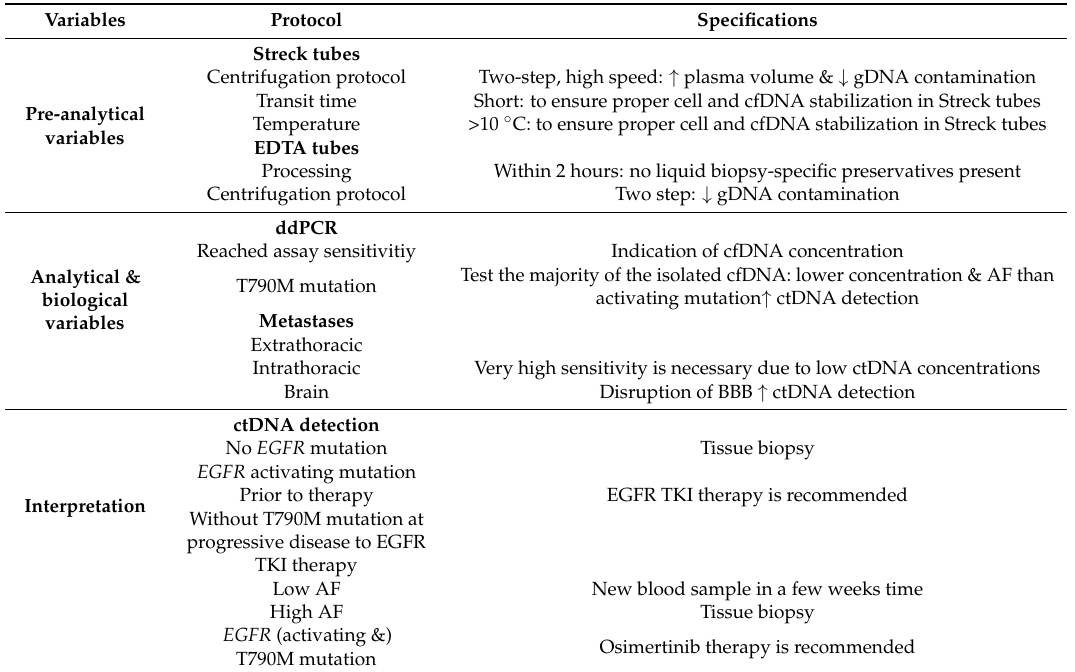
Table 3. Optimized workflow for liquid biopsy in a clinical